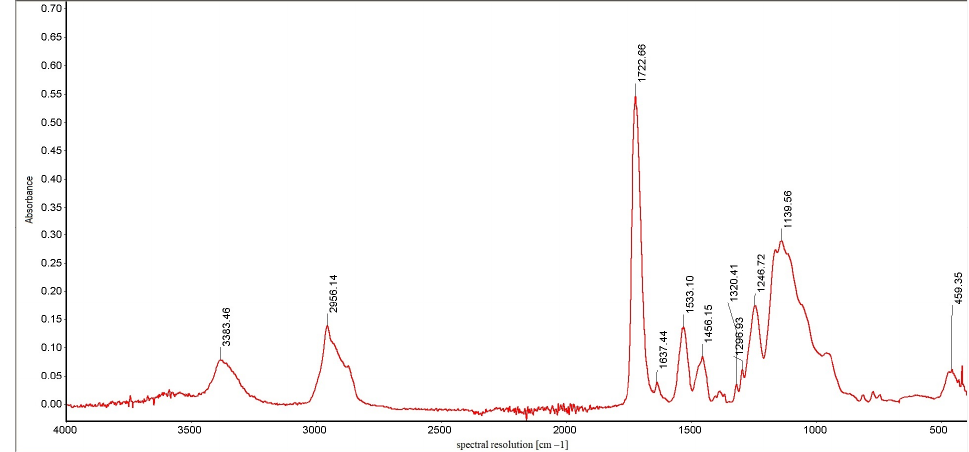
Figure 12. IR spectrum for sample 4.